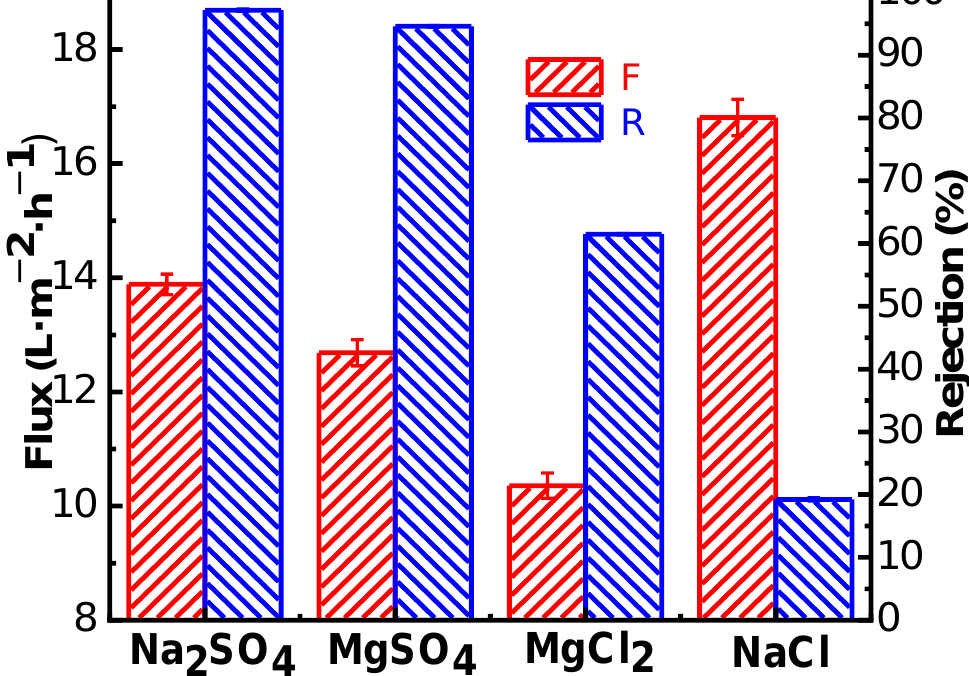
Figure 7. Separation performance of the PMIA HF TFC NF membrane on inorganic salts. As seen in Figure 7, the order of salt retention in different valence states by PMIA hollow fiber nanofiltration membrane is R Na2SO4 (98.30%) > R MgSO4 (94.60%) > R MgCl2 (61.48%) > R NaCl (19.24%), which is consistent with the order of retention of salt in different valence states by negative charge NF membrane in the literature [22,27]. This is mainly because Na 2 SO 4 and NaCl, and MgSO 4 and MgCl 2 have the same cation, respectively, and anions with the same charge as the membrane surface were repelled by electrostatic repulsion. The higher the valence state is, the more obvious the repulsion. Thus, the rejection rate of Na 2 SO 4 was greater than that of NaCl, and that of MgSO 4 was higher than that of MgCl 2 , which conformed to Donnan’s exclusion effect [24]. As for Na 2 SO 4 and MgSO 4 containing the same anion, the hydrated radius of Mg 2+ (0.428 nm) is higher than the hydrated radius of Na+ (0.358 nm), and the divalent Mg 2+ was easier to adsorbe on the surface of the neg- atively charged PMIA HF NFMs, which have adsorption and shielding effects on the sur- face charge of the membrane [36]. Therefore, when there was the same anion (SO4 2- ), the rejection rate of Na 2 SO 4 was greater than that of MgSO 4 , which was consistent with the results of the compound nanofiltration membrane with a negative charge [37]. The separation performance of the PMIA NFMs was different due to the different solution salt concentrations and operation pressure. Therefore, it was of great significance to study the relationship between salt solution concentration and membrane separation performance to understand the membrane separation process. Salt solutions of 1000, 2000, 3000, and 4000 ppm Na 2 SO 4 were prepared as the solution to be tested, and the influence of solution concentration changes on membrane separation performance were investi- gated at 25 °C and 0.35 MPa, and the results are displayed in Figure 8a. Figure 8a shows that the rejection rate and flux of the membrane decreased to some extent with the increase of salt concentration of the feed solution. When the operating pressure was constant, the osmotic pressure of the solution increased with the increase of solution salt concentration, and the driving force of the solution through the composite membrane decreased, thereby